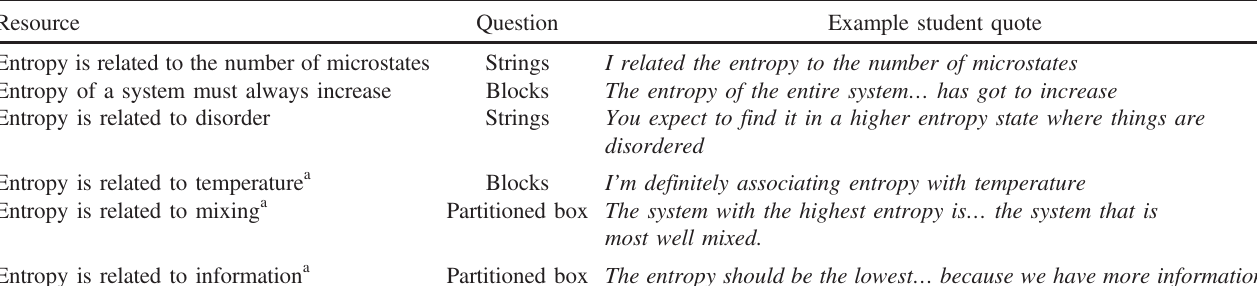
TABLE VII. Prevalent resources used by graduate students in this interview and student quotes exemplifying each resource. The first three resources were identified by Loverude [7] and also appeared in our study. The second three are new resources we identified. The second column gives the question from which the student quote